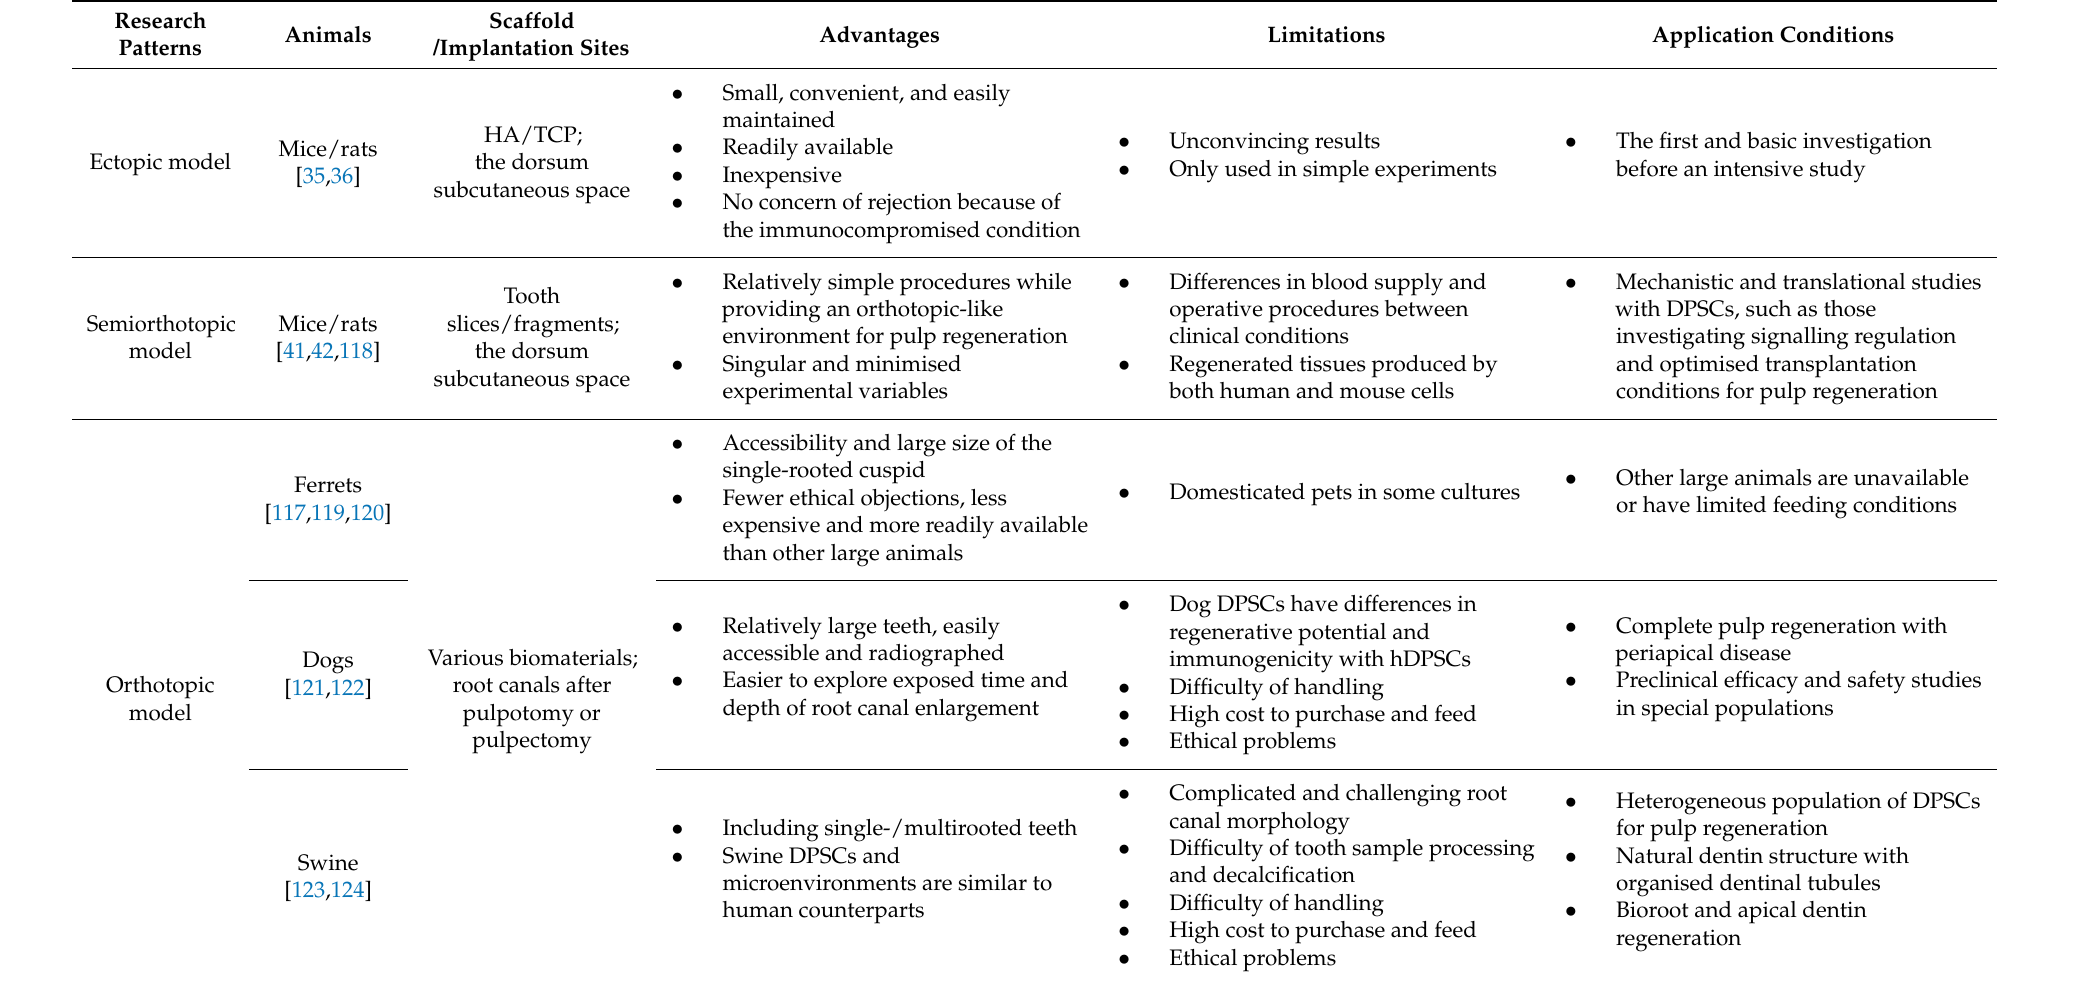
Table 7. Three preclinical research patterns and commonly used animal models in pulp